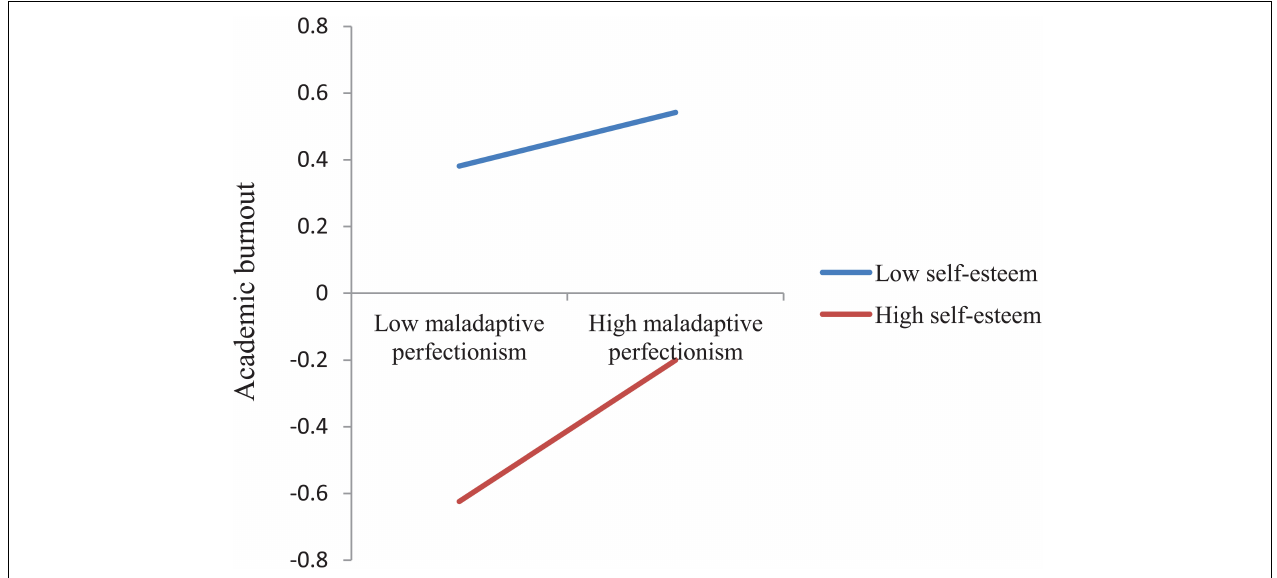
FIGURE 2 | The interaction effect of maladaptive perfectionism and self-esteem on academic burnout.